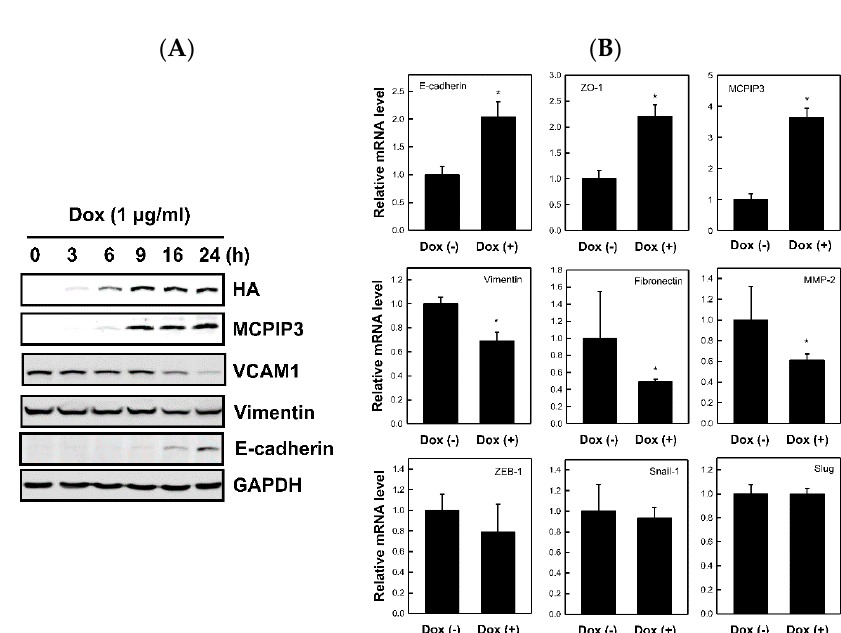
Figure 3. Time-dependent effects of MCPIP3 overexpression on protein expressions of epithelial–mesenchymal transition (EMT)-related marker genes in T-REx 293/HA-MCPIP3 cells. ( A ) Cells were treated with 1 μ g/mL of doxycycline (Dox) for 3, 6, 9, 16, and 24 h. Total proteins were collected to determining protein expressions of EMT-related marker genes by a Western blot analysis. ( B ) Cells were treated with 1 μ g/mL of doxycycline for 9 h. Total RNA was collected to determine mRNA expressions of EMT-related marker genes by a real-time RT-PCR analysis. Each value represents the mean ± SE from three independent experiments. * p < 0.05 vs. doxycycline-free cells. VCAM1: vascular cell adhesion molecule 1; GAPDH: glyceraldehyde-3-phosphate dehydrogenase. 2.4. Overexpression of MCPIP3 Inhibits Cell Migration and Affects EMT-Related Gene Expressions in Human CRC